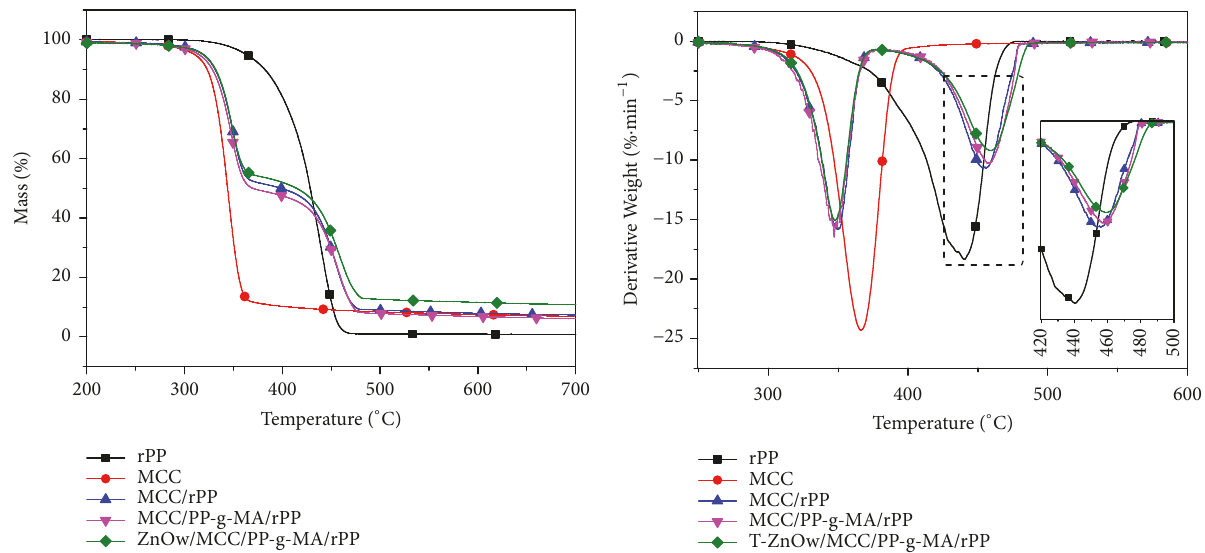
Figure 4: The TGA and DTG curves of MCC and rPP and the composites of MCC/rPP (60/40) and MCC/PP-g-MA/rPP (60/5/35) and T-ZnOw/MCC/PP-g-MA/rPP(5/55/5/35).